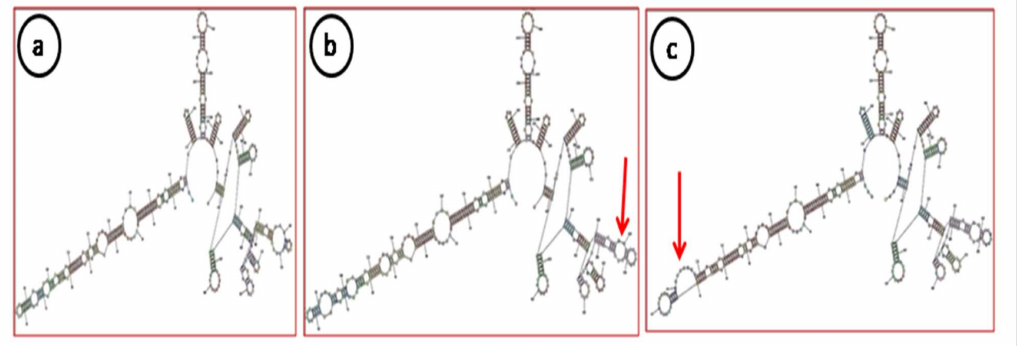
Figure 4. Secondary structure of apple hammerhead viroid: ( a ) Reference, ( b ) AHVd (GD), ( c ) AHVd (OS). The red arrows indicate the variations of nucleotides in our isolates in compari- son to reference